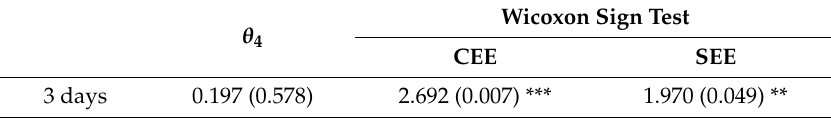
Table 6. Volatility reaction results to Brexit, +3 days event window length. θ